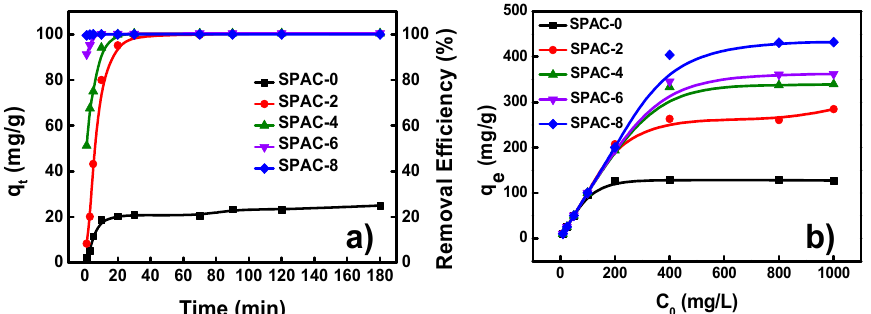
Figure 4. Effect of contact time and initial concentration on removal capacities of SPACs towards MB.